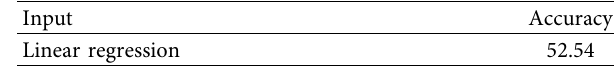
Table 11: ANOVA test.